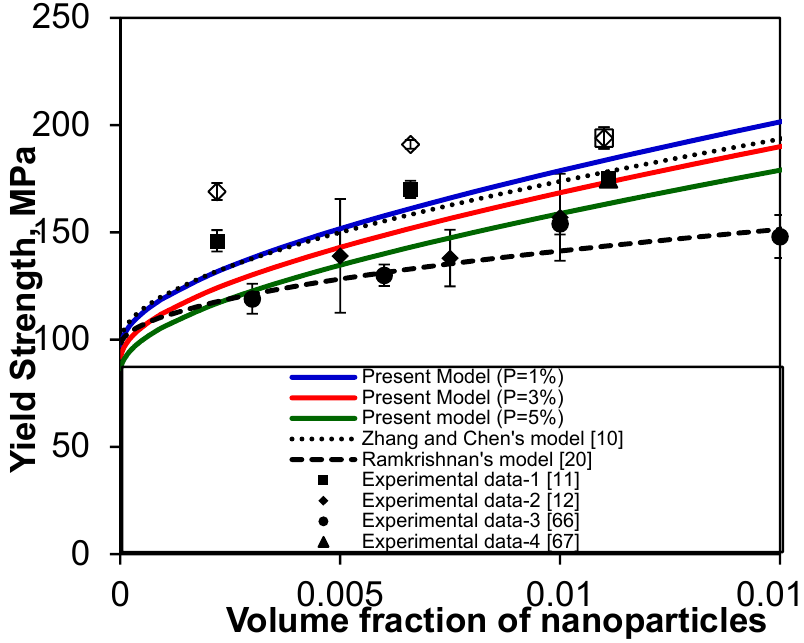
Figure 6. Comparison of the present model (solid curves) with the experimental data reported in references [11,12,66–69], in conjunction with Zhang and Chen’s model [10] and